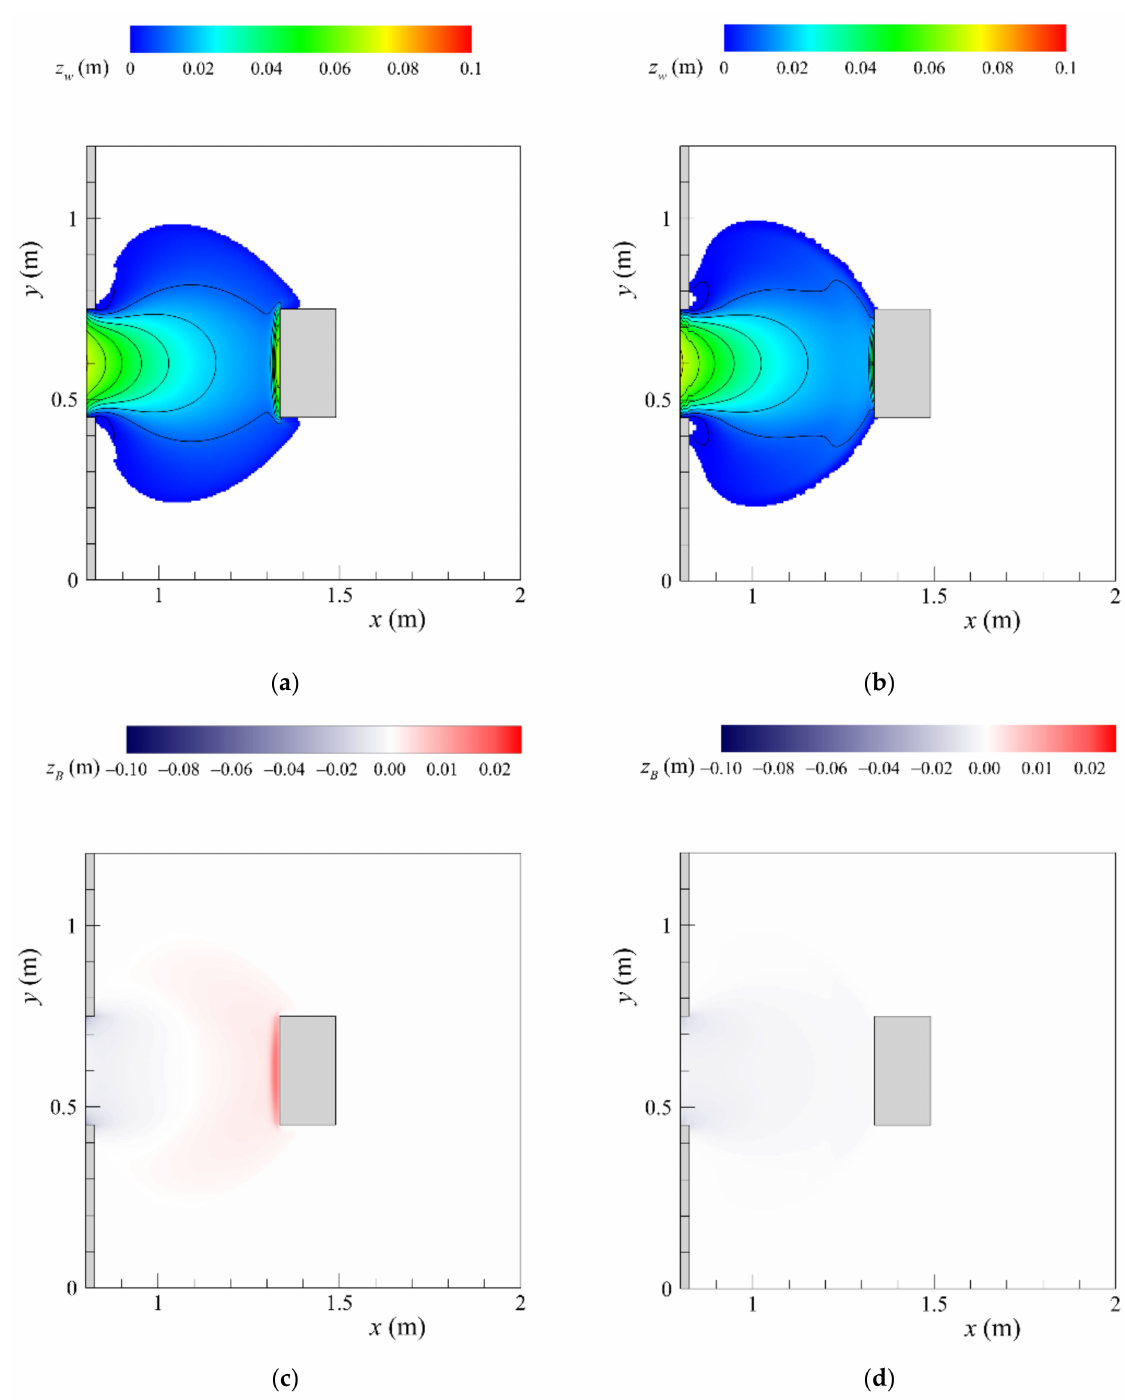
Figure 7. Results for PVC particles d = 5 × 10 − 4 m at t = 0.5 s: ( a ) free-surface elevation predicted by the SVEM; ( b ) free-surface elevation predicted by the TPM; ( c ) bottom elevation predicted by the SVEM; ( d ) bottom elevation predicted by the